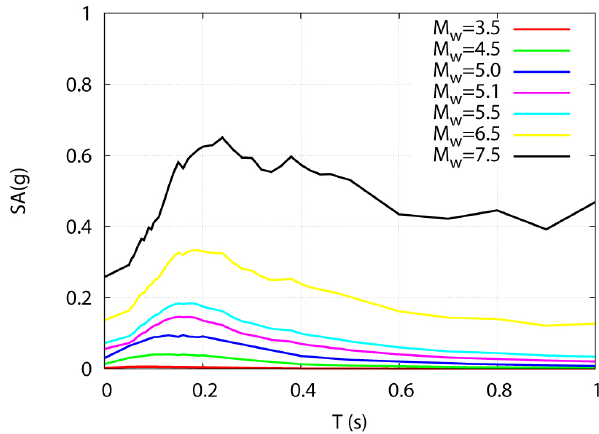
Figure 2. Attenuation of PGA for shallow earthquakes and stiff soil sites. Magnitudes above 5 have been attenuated with Ambraseys et al. (2005) and magnitudes equal or below 5 with Bragato and Slejko (2005).